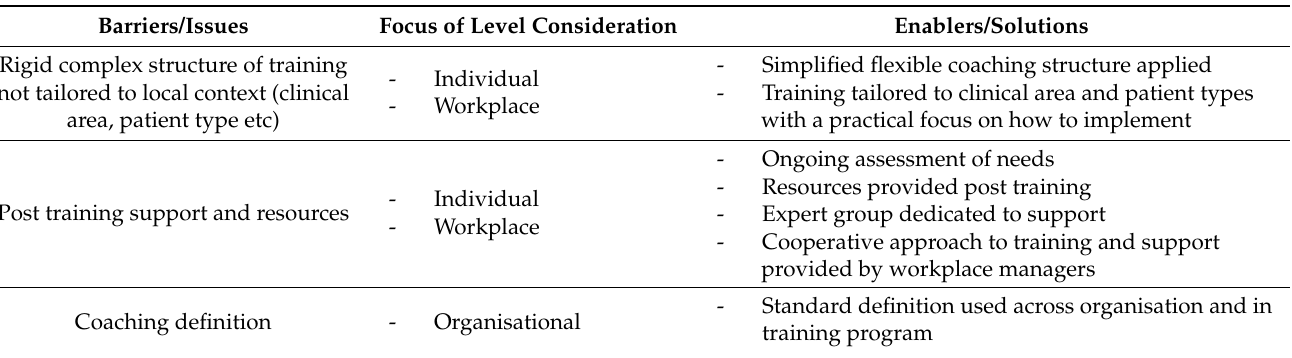
Table 2. Barriers and solutions to translating health coaching in